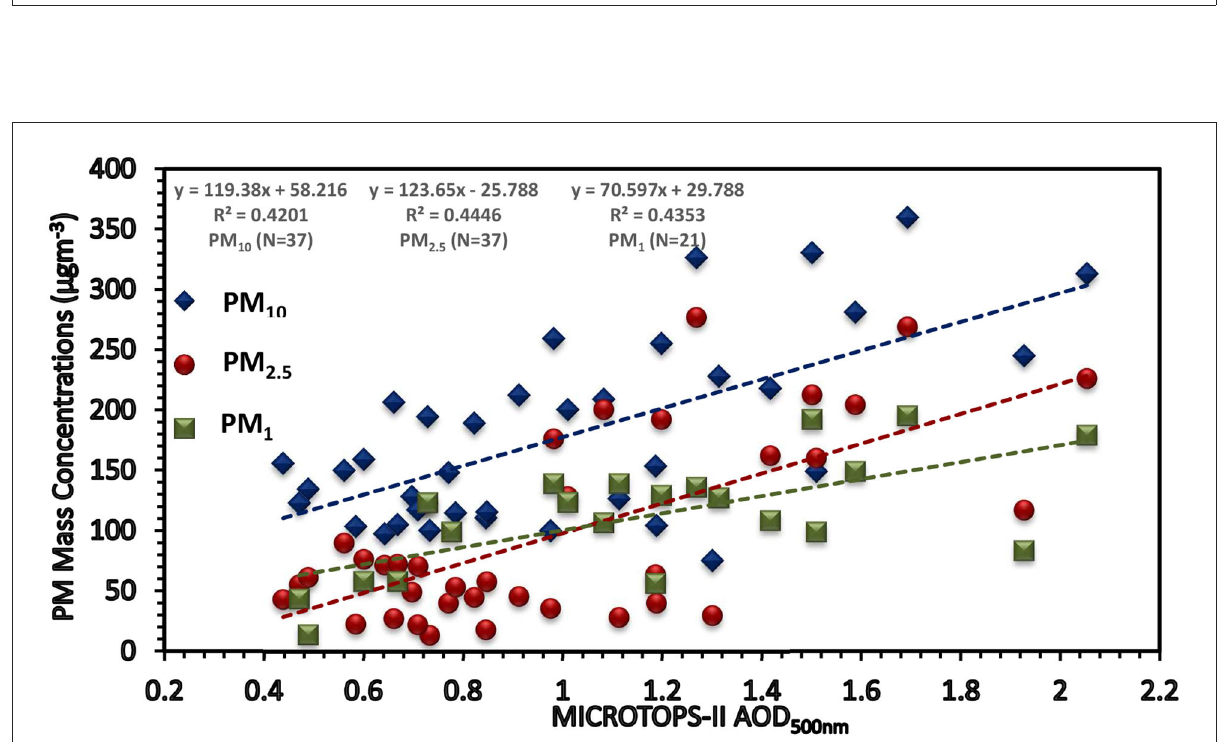
FIGURE10 Correlation between MICROTOPS-II AOD (500nm) and particulate matters (PM 1 , PM 2.5 , and PM 10 ).